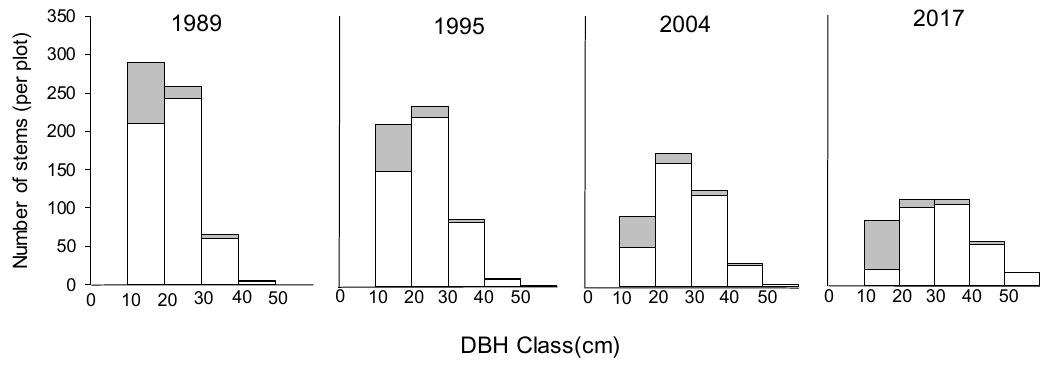
Figure 5. Change of diameter at breast height (DBH) class distributions in the permanent plot during the measuring period. Open bars represent stems of Castanopsis cuspidata , and shaded area stems of other tree species (the area of per plot was 0.7 ha).